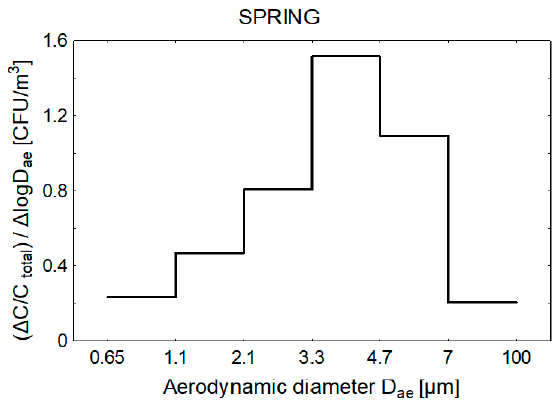
Figure 3. Size distribution of bacterial aerosols in outdoor air in spring.